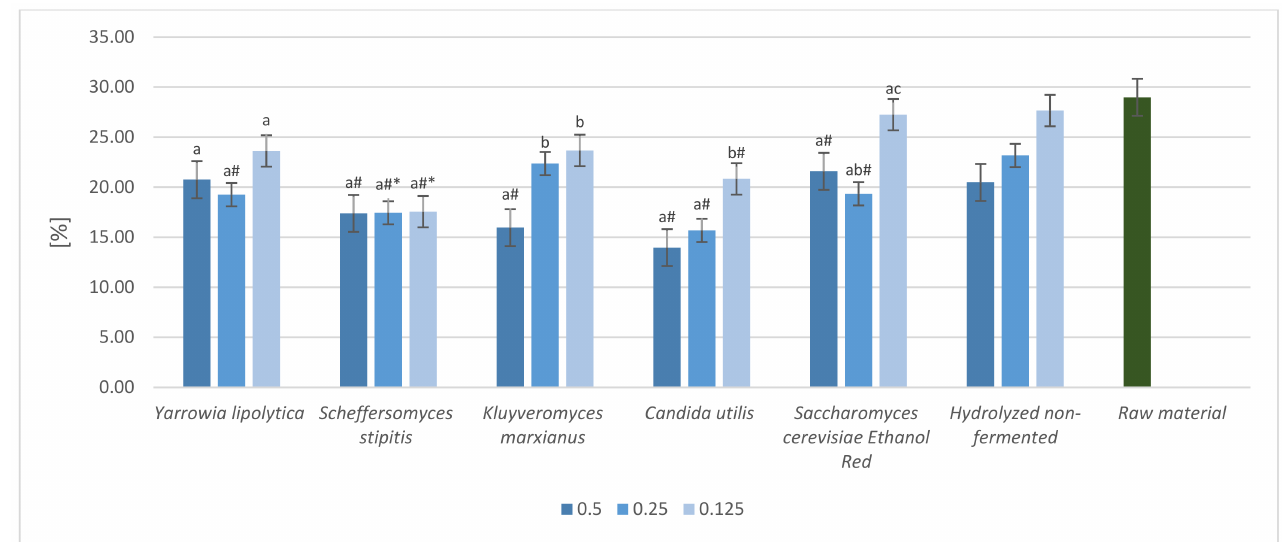
Figure 7. Crude Fiber (CF) content after pre-hydrolysis and yeast cultivation with dried sugar beet pulp hydrolyzed with different enzyme doses (0.5 mL/10 g DM; 0.25 mL/10 g DM; 0.125 mL/10 g DM). a, b, c—indicators of statistically significant difference, mean values for strain with different letters are significantly different ( p < 0.05). *—indicator of significant difference relative to mean value of hydrolyzed non-fermented sample, #—indicator of significant difference relative to the mean value for the raw material ( p <